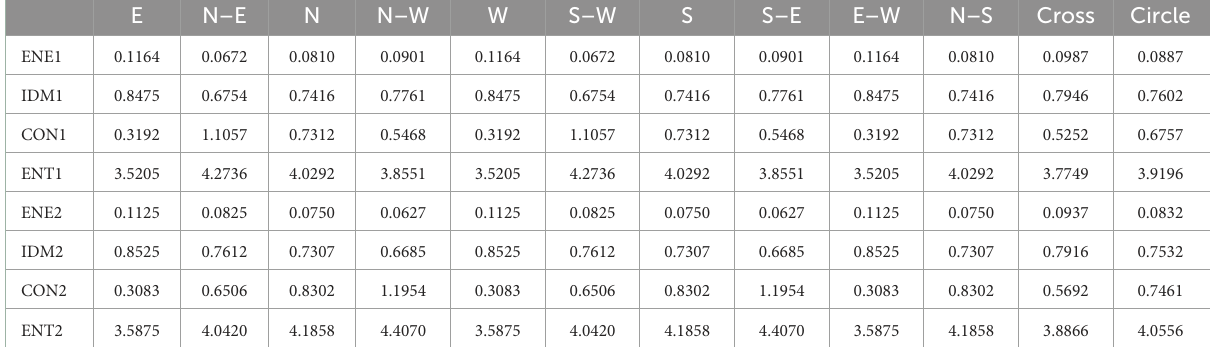
TABLE 6 Relevant calculation data for quantitative analysis of echo homogeneity of white matter in plane three